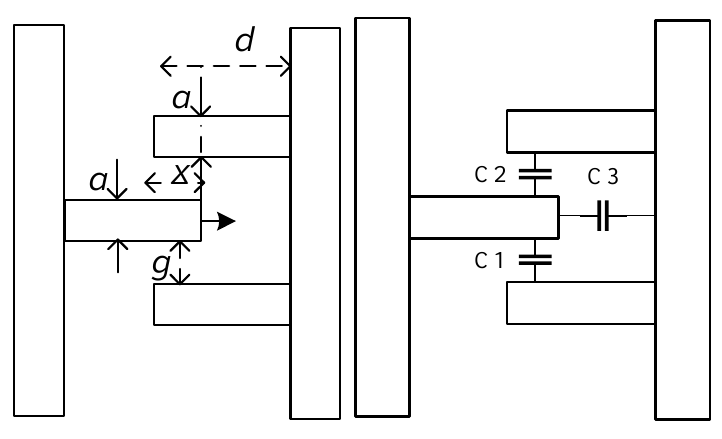
Figure 3. Schematic of the driving part.